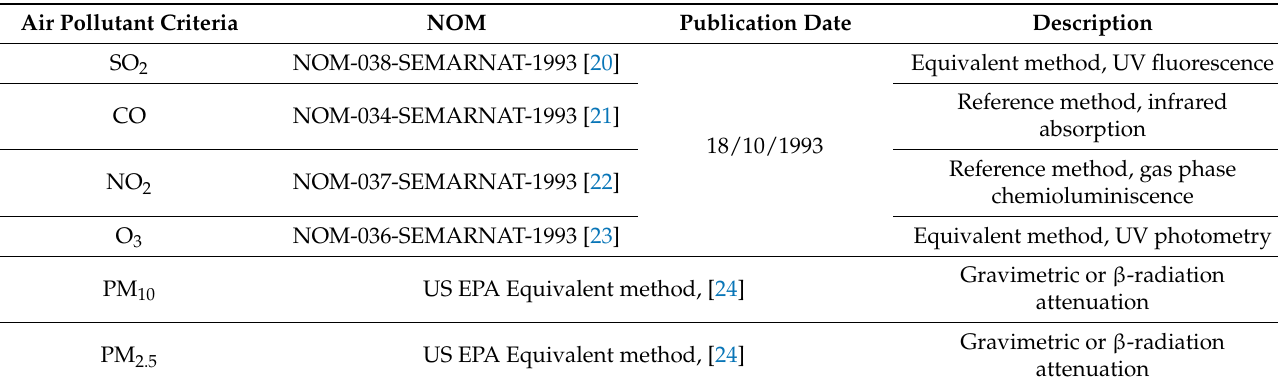
Table 2. Mexican technical NOMs and standardized measuring